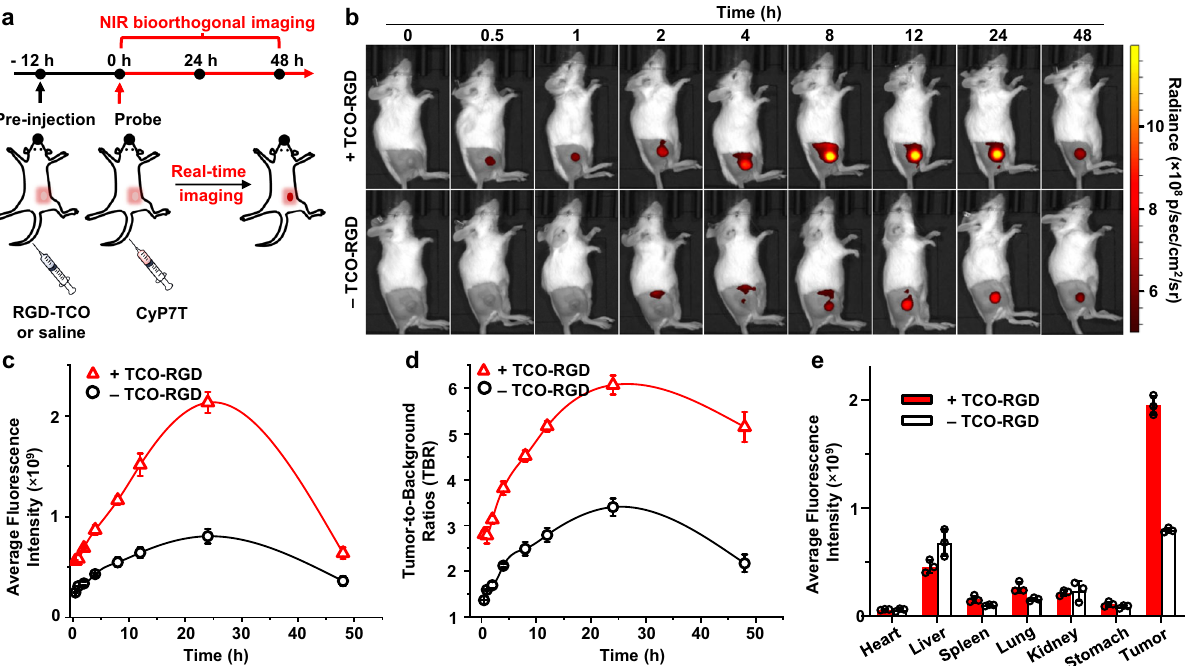
Fig. 7 In vivo bioorthogonal NIR imaging for 4T1 tumor-bearing mice. a Timeline of RGD-TCO, CyP7T injection, and NIR imaging. Mice were pre-injected with TCO-RGD (10 nmol) or saline, followed by injection of CyP7T (5 nmol) 12 h later. b NIR imaging was performed at various timepoints (0, 0.5, 1, 2, 4, 8, 12, 24, 48 h) post-injection of CyP7T. c Fluorescence signal intensity in tumor tissue and d Tumor-to-background ratio (TBR) over time, n = 3. TBR was determined by (tumor ROI — background ROI)/background ROI. e Fluorescence intensity analysis of excised organs harvested from mice 24 h post- injection of CyP7T. Data are presented as mean ± SD. ( n = 3 biologically independent mice per